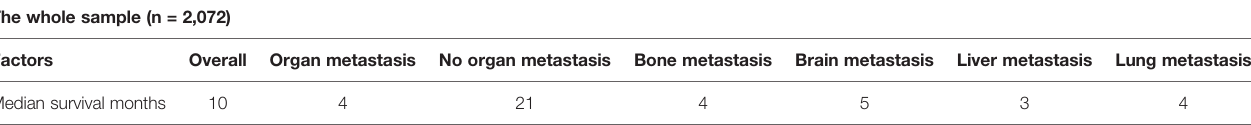
TABLE 6 | Median survival